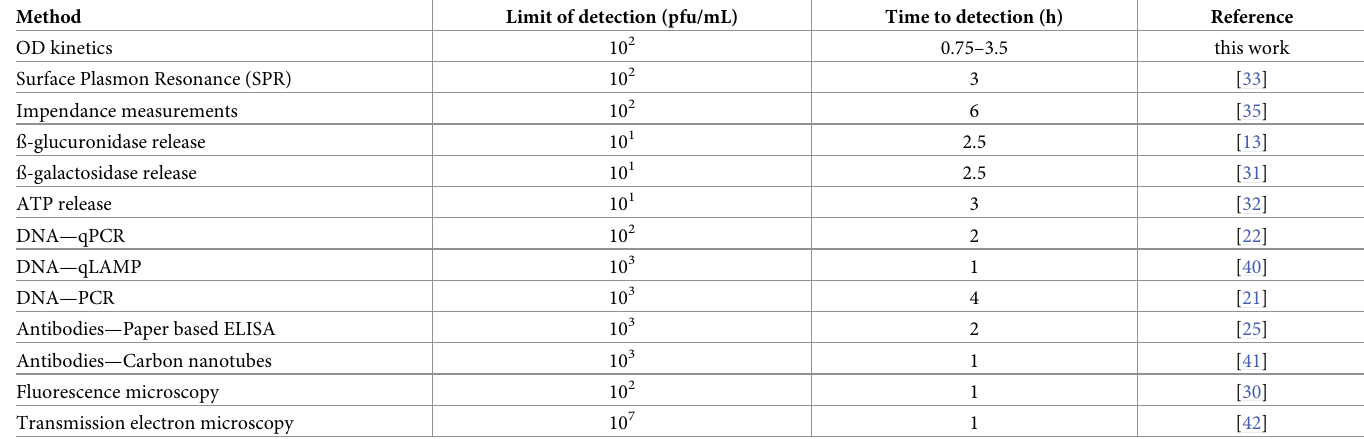
Table 1. Sensitivity, expressed as the limit of detection, and time required for detection, in different methods currently available for phage